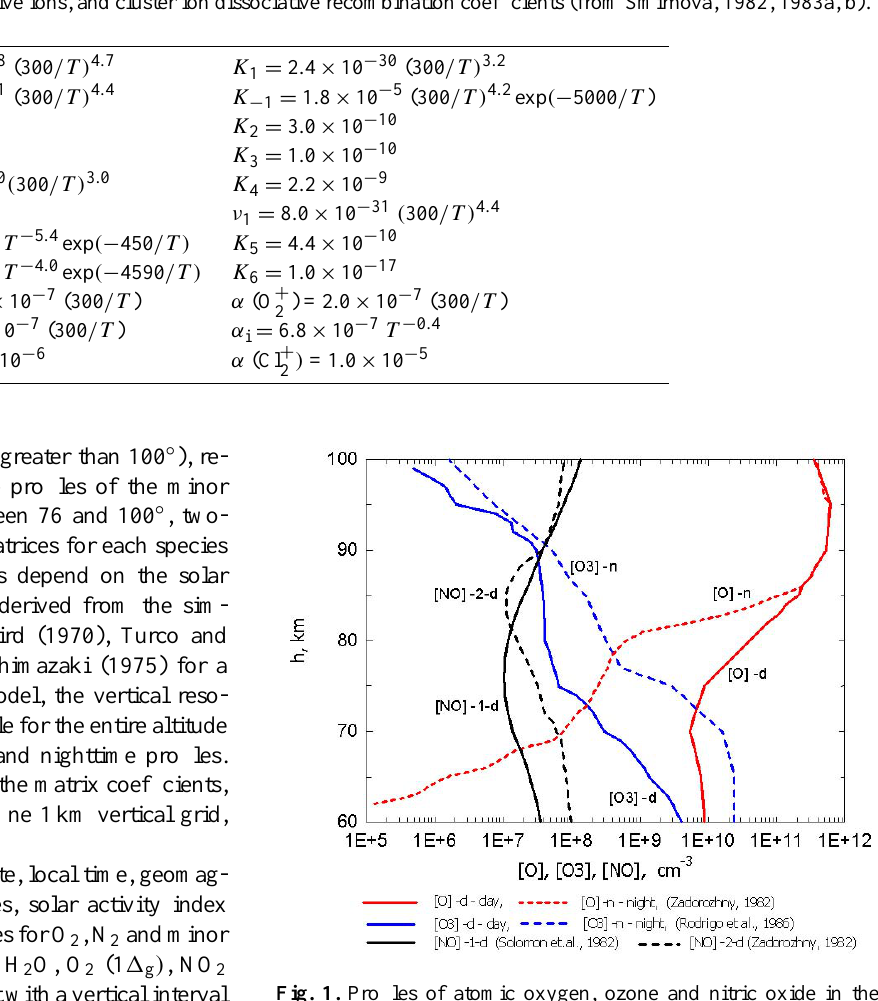
hydration channel efficiencies, recombination coefficients 2